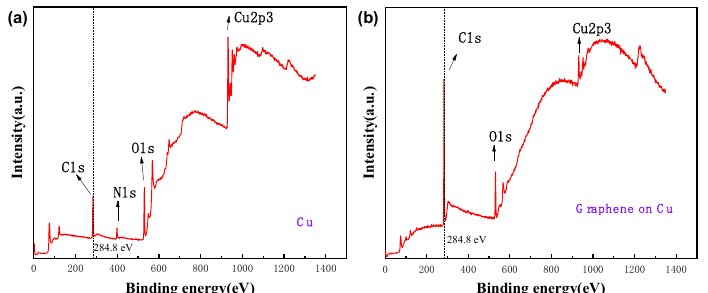
Figure 6. X-ray photoelectron spectroscopy of ( a ) the pristine copper foil and ( b ) the graphene- modified copper